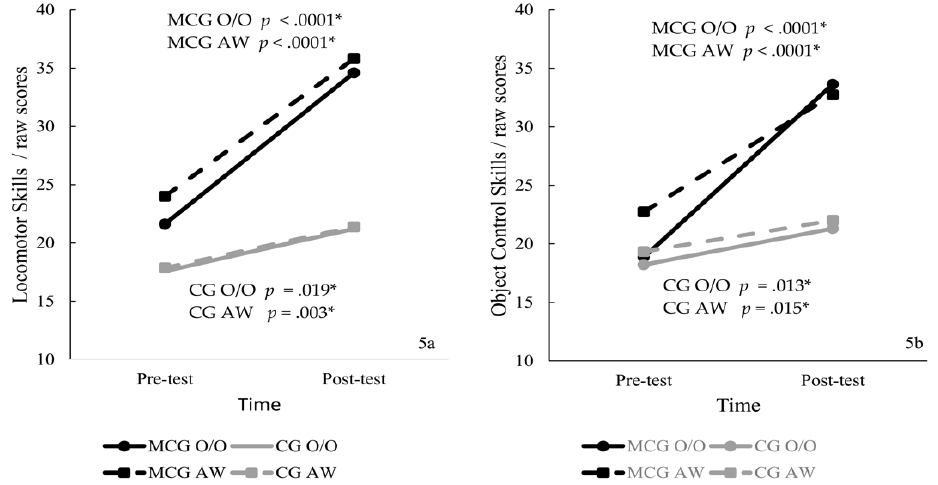
Figure 5. Locomotor ( 5a ) and object control ( 5b ) skills by group (* significant results).